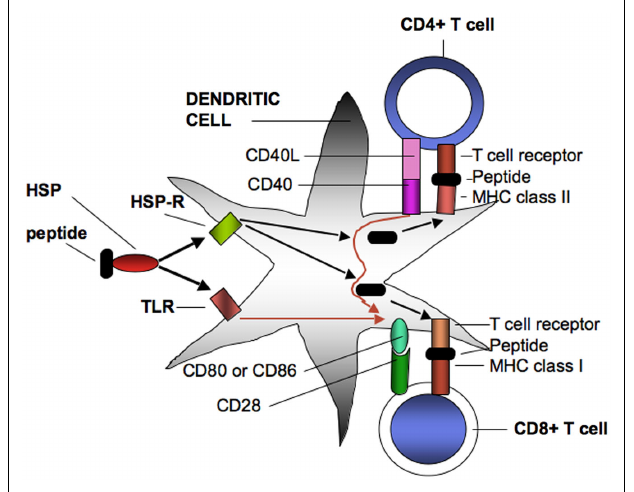
FIGURE 1 | Heat shock protein–peptide complexes extracted from tumor cells interact with endocytosing receptors (HSP-R) such as SRECI or signaling receptors (TLR) such asTLR4 on DC. SREC1 mediates uptake and intracellular processing of antigens and the presentation of resulting peptides on surface MHC class I and MHC class II proteins. MHC class II receptor–peptide complexes then bind toT cell receptors on CD4 + cells. One consequence of binding is interaction of CD40 ligand on the MHC class II cell with CD40 on the DC leading to the licensing interaction that results in enhanced expression of co-stimulatory proteins on the DC cell surface.The licensed DC may then interact with CD8 + T cells throughT cell interaction with MHC class I peptide complexes. This effect will be enhanced by simultaneous interaction of CD80 or Cd86 co-stimulatory complexes on the DC with CD28 on the CD8 + cells, leading to effective CD8 + CTL that can lyse tumor cells.T cell programming can also be amplified by signals emanating from activatedTLR that can boost levels of CD80 and CD86 as well as inflammatory cytokines (not